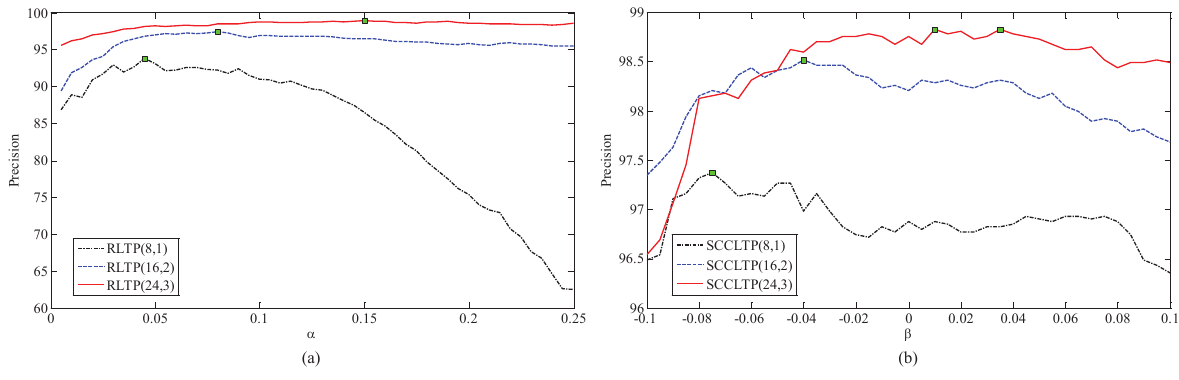
Figure 5. The curve of precision vs . α and β on TC10. ( a ) The results of RLTP(8,1), RLTP(16,2) and RLTP(24,3). ( b ) The results of SCCLTP(8,1), SCCLTP(16,2) and SCCLTP(24,3).